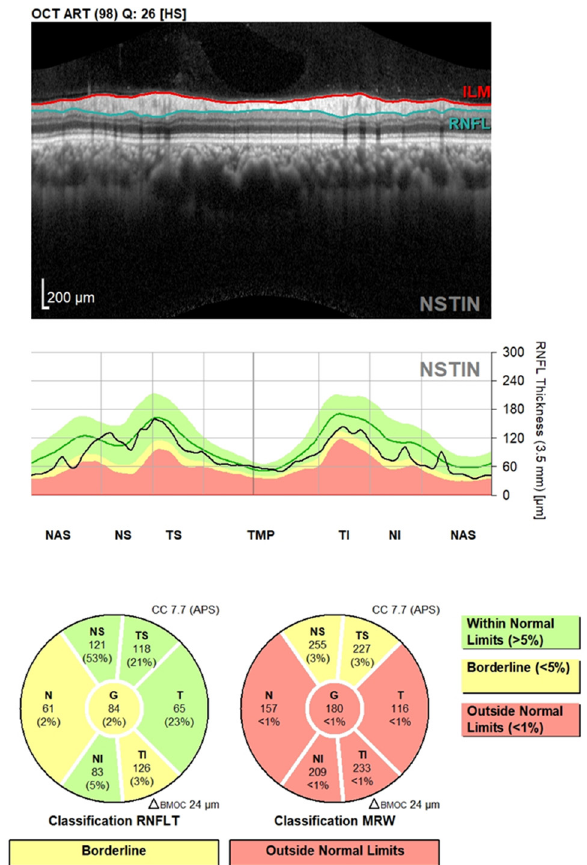
Figure 11. Glaucoma detection report based on RNFL thickness and MRW in various retinal zones using OCT.